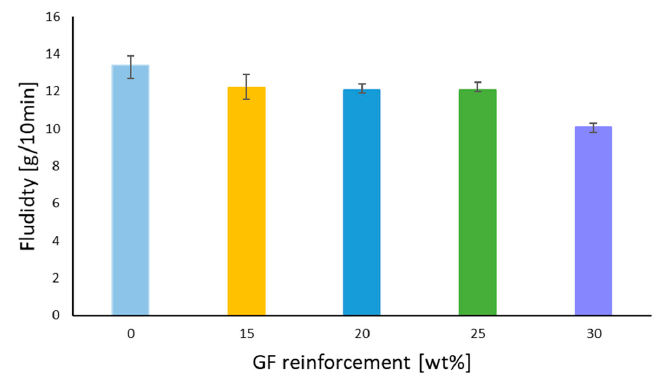
Figure 14. Fluidity vs. GF reinforcement rate.